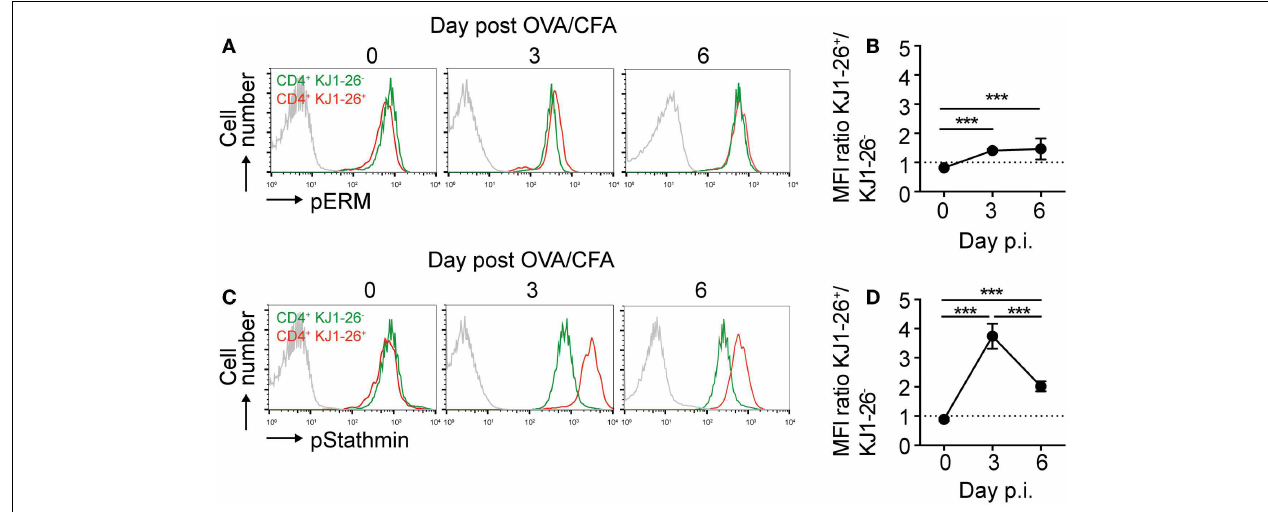
FIGURE 4 | Dynamic regulation of pERM and pStathmin levels in DO11.10 CD4 + T cells . (A) Representative flow cytometry plots showing intracellular pERM levels on endogenous CD4 + versus KJ1–26 + DO11.10 CD4 + T cells on days 0, 3, and 6 post OVA/CFA immunization. The gray line represents secondary Ab only. (B) Ratio of pERM levels on endogenous CD4 + versus KJ1–26 + DO11.10 CD4 + T cells. (C) Representative flow cytometry plots showing intracellular pStathmin levels on endogenous CD4 + versus